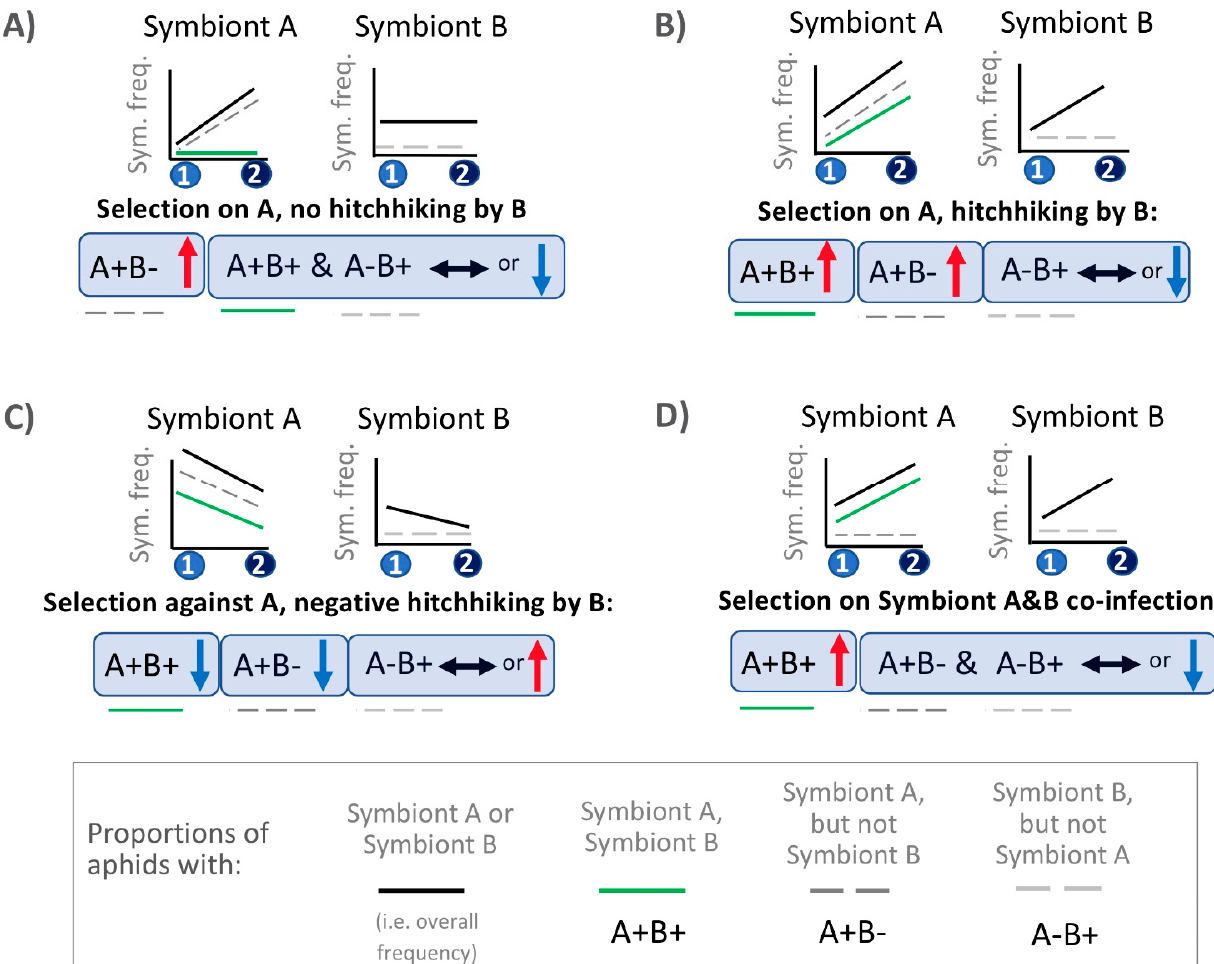
Figure 1. Hitchhiking or selection? Key for (co-)infection context deconstruction and its use in interpreting the symbiont dynamics shown in later figures. ( A ) Possible pattern expected if: there is positive selection on aphids with Symbiont A due to the symbiont’s fitness/phenotypic impacts, and if Symbiont B rarely lives with Symbiont A, showing, thus, no response via hitchhiking. ( B , C ) Patterns consistent with selection on aphids with one symbiont and hitchhiking by another. Under this scenario, selection acts on the phenotypic effects conferred by Symbiont A. This symbiont commonly lives with Symbiont B, which does not strongly impact Symbiont A’s fitness/phenotypic impacts, and which does not, itself, alter fitness at the given time. Symbiont B’s frequency dynamics, thus, extend from selection acting on its co-infecting Symbiont A partner. ( D ) Pattern expected if selection acts on a phenotype conferred due to the joint actions of two co-infecting symbionts. In this case, it is the co-infection that is under selection (only positive selection scenario shown for panel ( D )—as done also for panel ( A )). The boxed legend at the bottom decodes the line -color and -dashing schemes used to illustrate symbiont and (co-)infection context frequencies in ( A – D ). Note that y-axes represent the frequency of each symbiont or the particular (co-)infection type. Colored circles on the x -axis represent different sampling times.